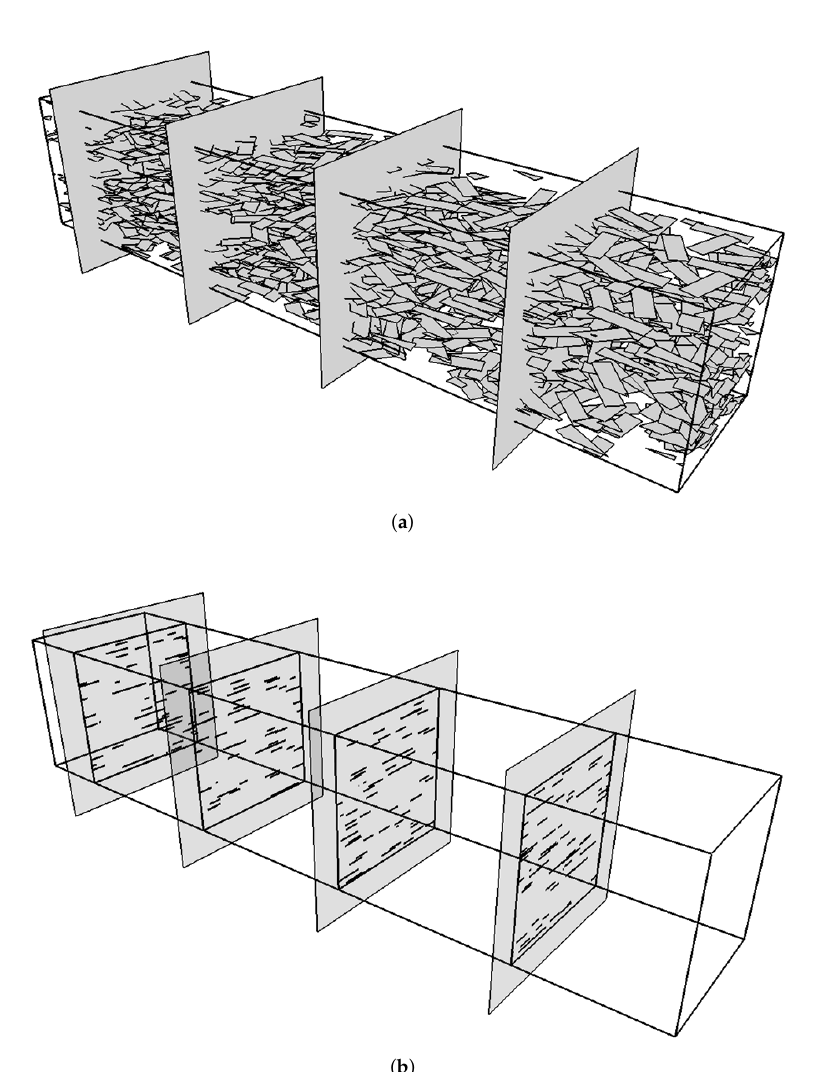
Figure 2. Schematic showing a numerical sectioning experiment. ( a ) 3D RVE containing flakes with their planes parallel to the X - Z plane and having random orientations in the X - Y plane. Shown as well are the sectioning planes. ( b ) The sectioning planes showing only the flake in- tersections as lines of variable length. The number of sections defines the ensemble size (here K = 4). The number of intersections (lines) in each frame, defines the sample size (here M ∼ 50 for clarity). Reprinted from Papathanasiou et al.